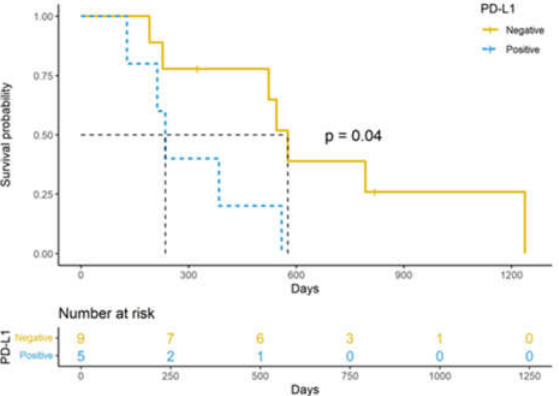
Figure 3. Kaplan–Meier curves of survival time of 14 dogs with AGASACA treated with surgery Figure alone.